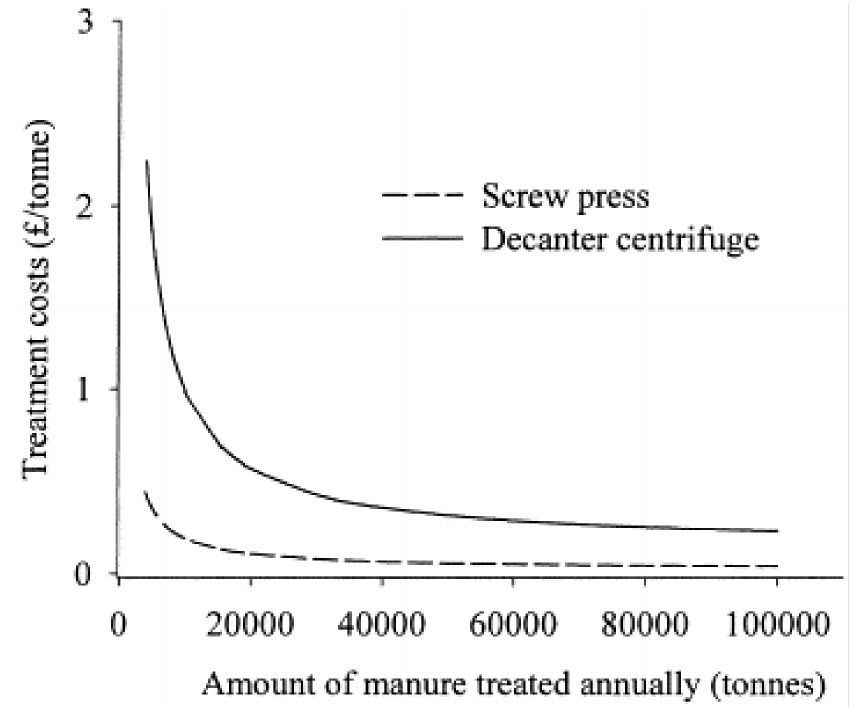
Figure 3. Costs in £ t − 1 for slurry separation using a screw press and a decanting centrifuge influenced by the amount of animal manure treated annually (reproduced by permission from Møller et al. 2000